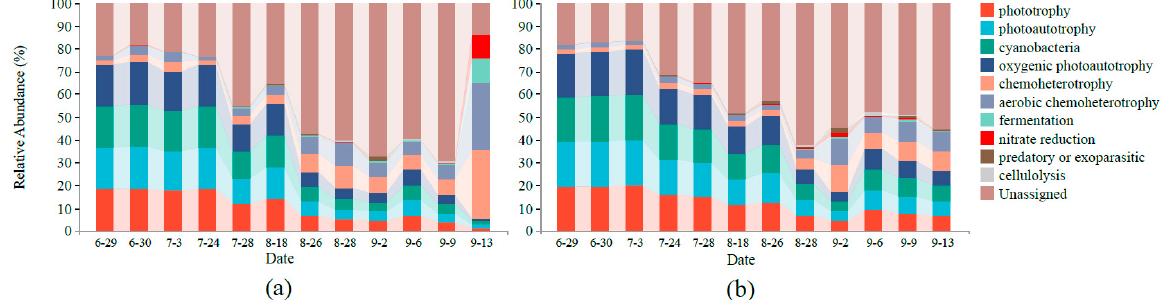
Figure 10. Prediction of the bacterial functional profiles of the core microbiome in the two ponds using FAPROTAX software: ( a ) control pond; ( b ) MC-treated pond.